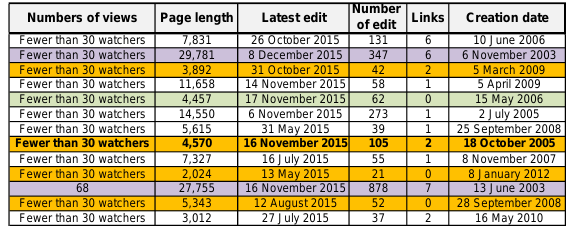
Table 5. The Wikipedia page attributes of the 13 landmarks From all landmarks ranked as 9, the "Olympic Tower” (8th row,